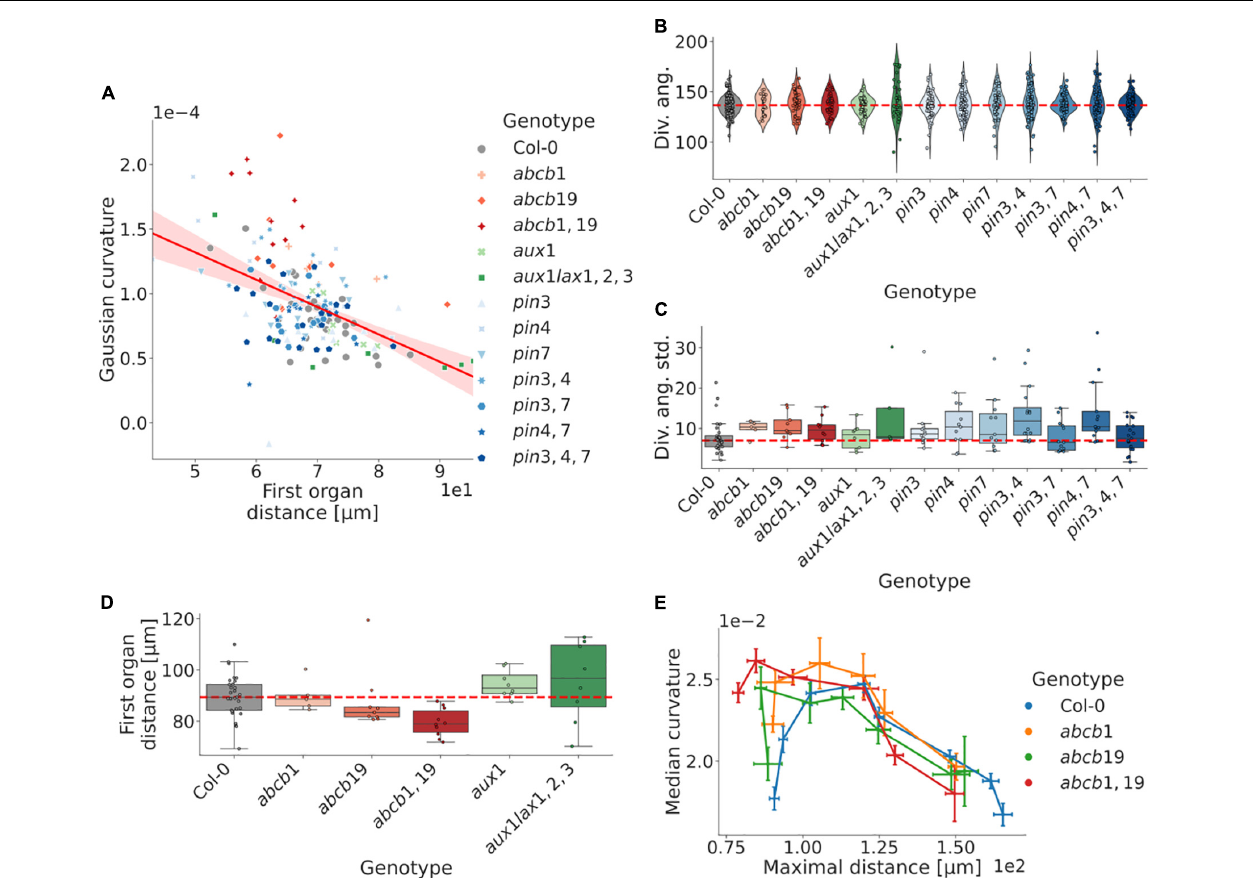
FIGURE 5 | Robustness in phyllotaxis is dependent on non-local auxin regulation, whereas local auxin transport affects shoot morphology. (A) The inflorescence meristem curvature correlates with the first organ distance (least-squares regression: r = − 0.48, p = 1.23e-10). Outliers further than 100 µ m from the meristem apex removed from the analysis. (B) Distributions of divergence angles for WT and five auxin transport related mutant genotypes. Each data point represents the average divergence angle in a plant. Typically 4–8 organs can be identified per plant. Perturbed plants are more prone to include severely aberrant angles. (C) Per-plant distributions of standard deviations from the in divergence angles around the canonical WT average (137.5 ◦ ). The majority of perturbed plants exhibit increased variability in the internal angles. (D) Size-distributions as defined by the distance from the inflorescence domain centre of mass to the first organ counterpart. Mutations in the ABCB efflux transporter genes trend toward smaller shoots. (E) Curvature-distance distributions for organs in the mutations in the ABCB efflux transporter genes, which affect the plastochron for earlier primordia. The maximal distance refers to the maximal euclidean distance for the organ vertices relative to the inflorescence apex. The corresponding organ index in perturbed plants is generally at a later developmental stage than its WT counterpart. Error bars in (E) show the standard error of the mean, whereas points represent the group means; lines are ordered in terms of the corresponding organ index. Dashed red lines represent the WT distribution median in (B–D) . Corresponding significance tests are reported in Supplementary Figure 6